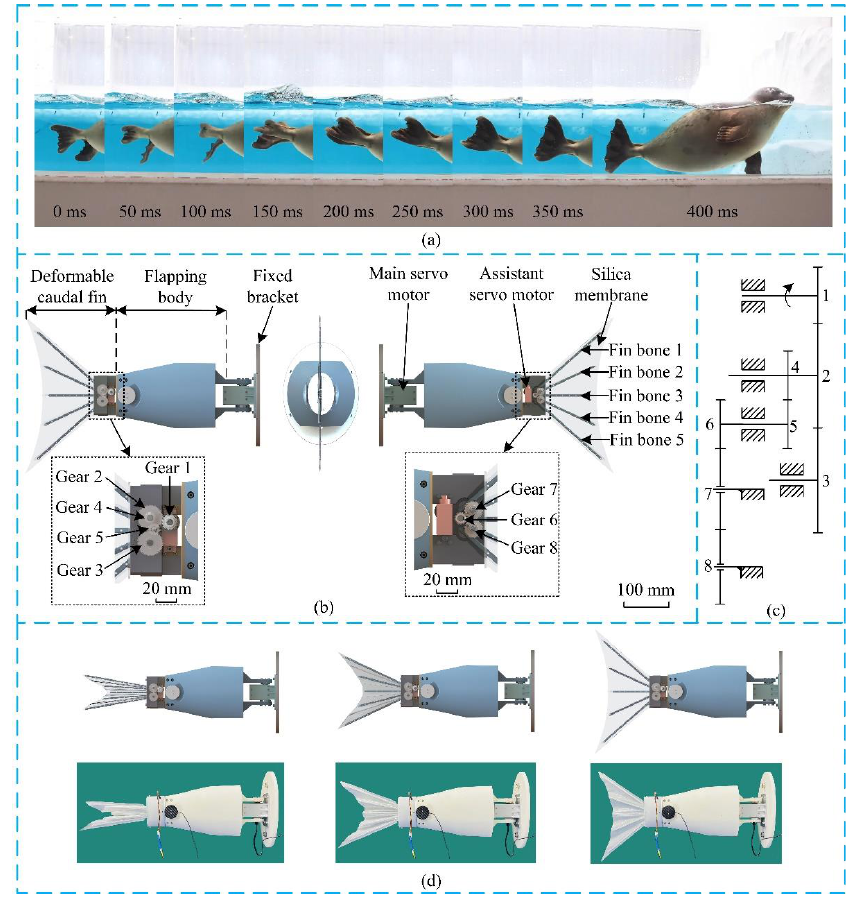
Figure 1. The design of the deformable caudal fin: ( a ) Snapshots of a swimming seal’s webbed feet [35]. ( b ) CAD model of the deformable caudal fin. ( c ) Gear-based transmission mechanism. ( d ) The prototype of the deformable caudal fin platform and states of a folded caudal fin becoming un- folded.